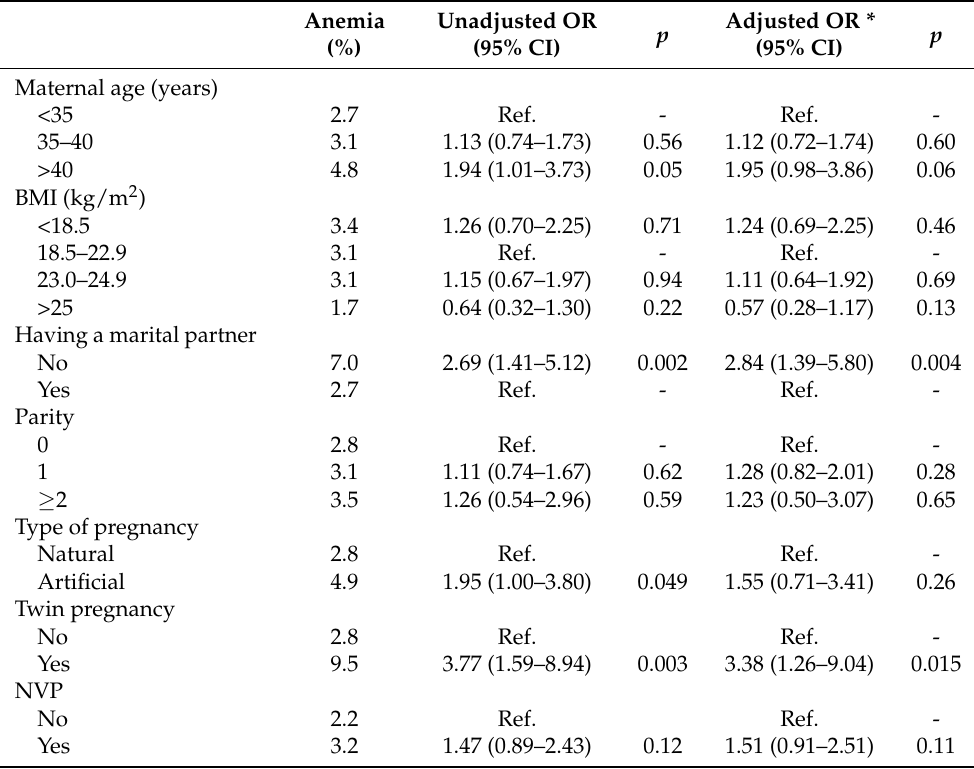
Adjusted OR * Anemia Unadjusted OR p p (95% CI) (%) (95% CI)